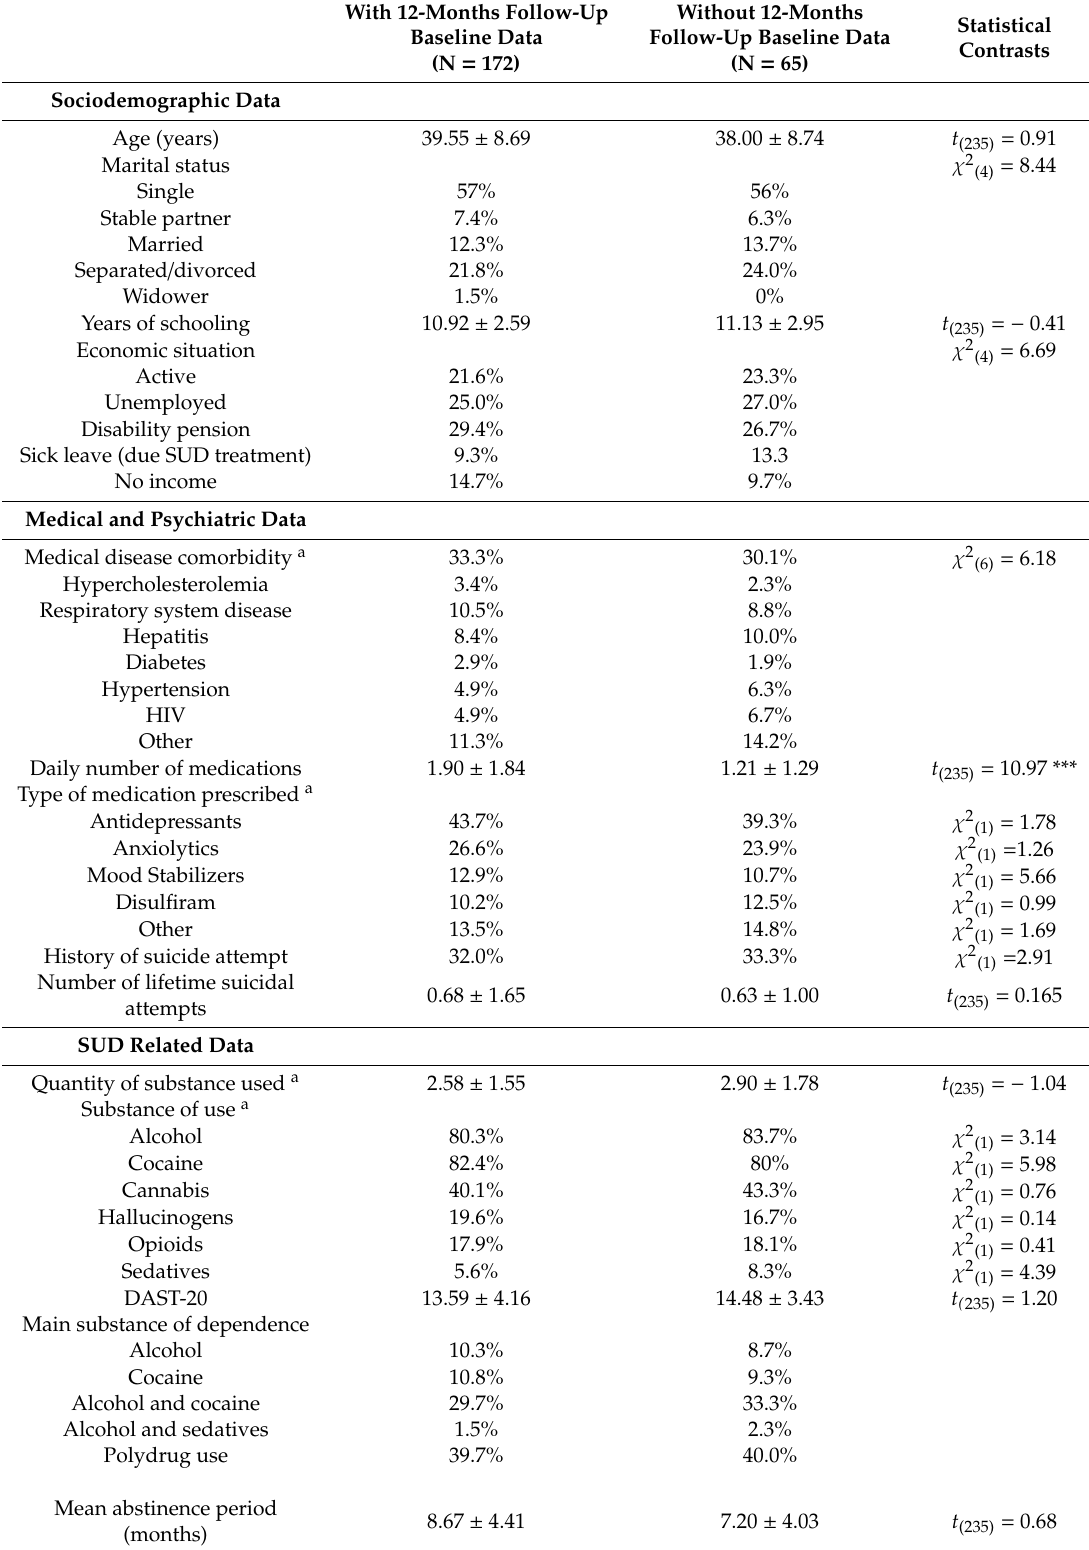
Table6. Attritionanalysisforsociodemographicandclinicalvariablesbetweenpatientswhohad / didnot had follow-up data at 12-months. Means and standard deviation or percentages, and statistical